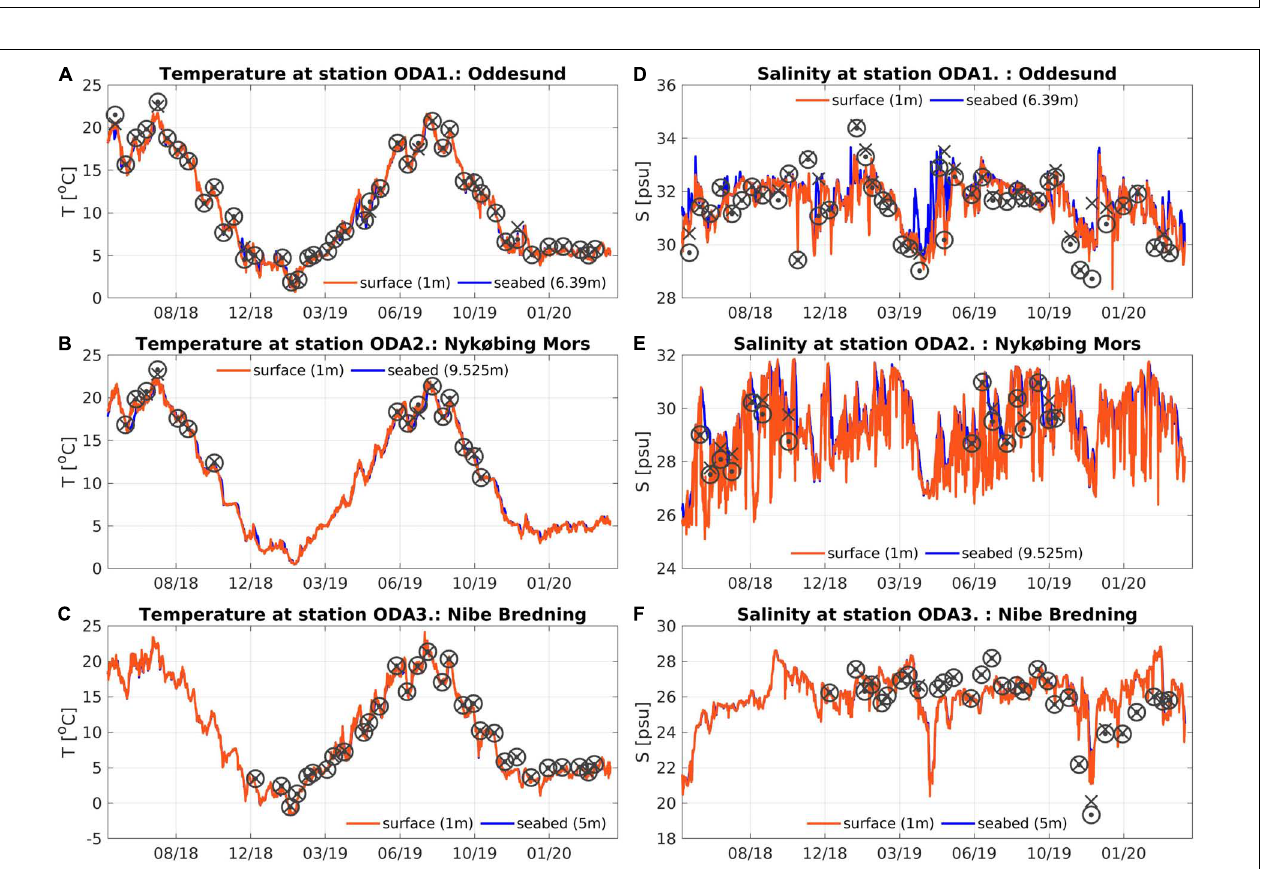
FIGURE 9 | Scatter map of modeled and observed surface-bottom difference: (A) temperature; (B) salinity. Each marker represents a station with at least 20 observations.